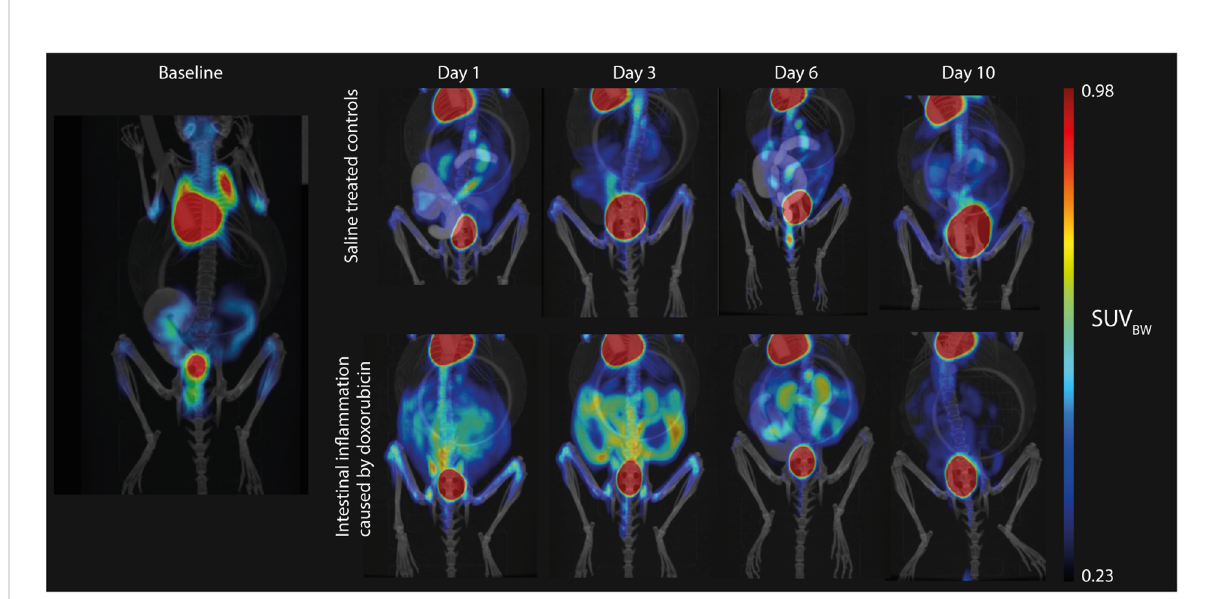
FIGURE 3 Representative examples of the 2-[ 18 F]FDG uptake on the PET/CT scans. Uptake is very high in the heart and bladder. Left: Baseline hybrid PET/ CT scan with low uptake in the intestines due to variable intestinal muscle activity. Upper panel: Sequential images from a mouse in the control group with consistently low intestinal uptake, which was comparable to baseline levels. Lower panel: Sequential images from a mouse in the doxorubicin-treated group with highly increased intestinal uptake on days 1 to 6.